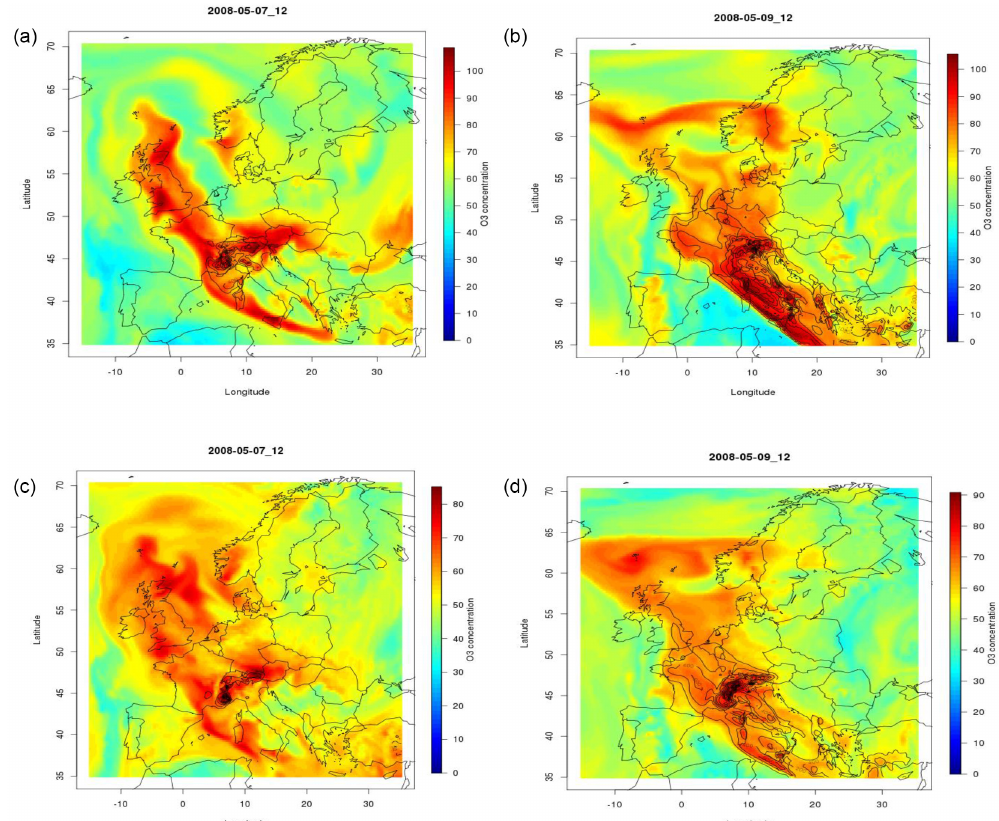
Figure 10. (a, b) CHIMERE simulations of the ozone field at 3km altitude (in ppb) with the iso-contours of the high tropospheric tracer (in black; arbitrary units) for 7 May 2008 (left column) and 9 May 2008 (right column). (c, d) Same as in (a, b) but for 1.5km